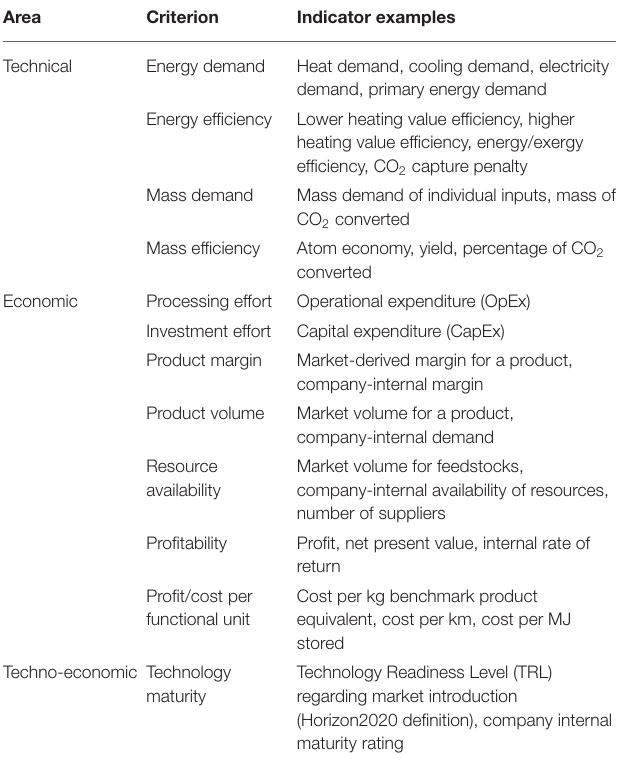
TABLE 4 | List of example criteria and indicators.